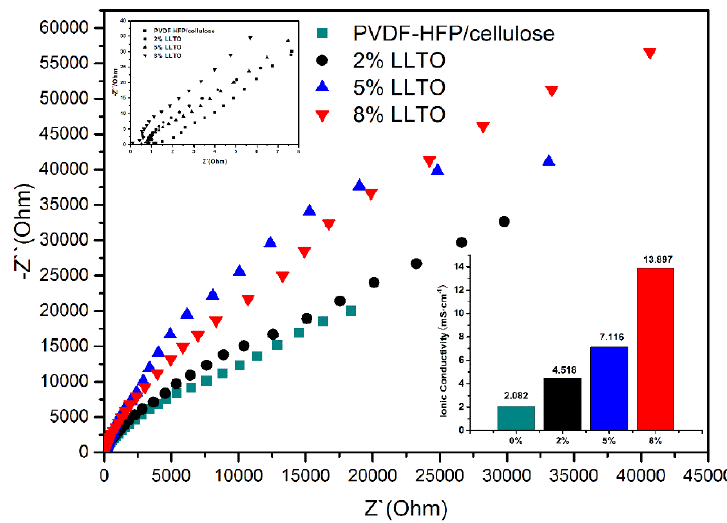
Figure 5. Nyquist plots of stainless steel/electrolyte ‐ soaked separator/stainless steel cells at 20 °C, insets are magnified Nyquist plot and ionic conductivity of separators.